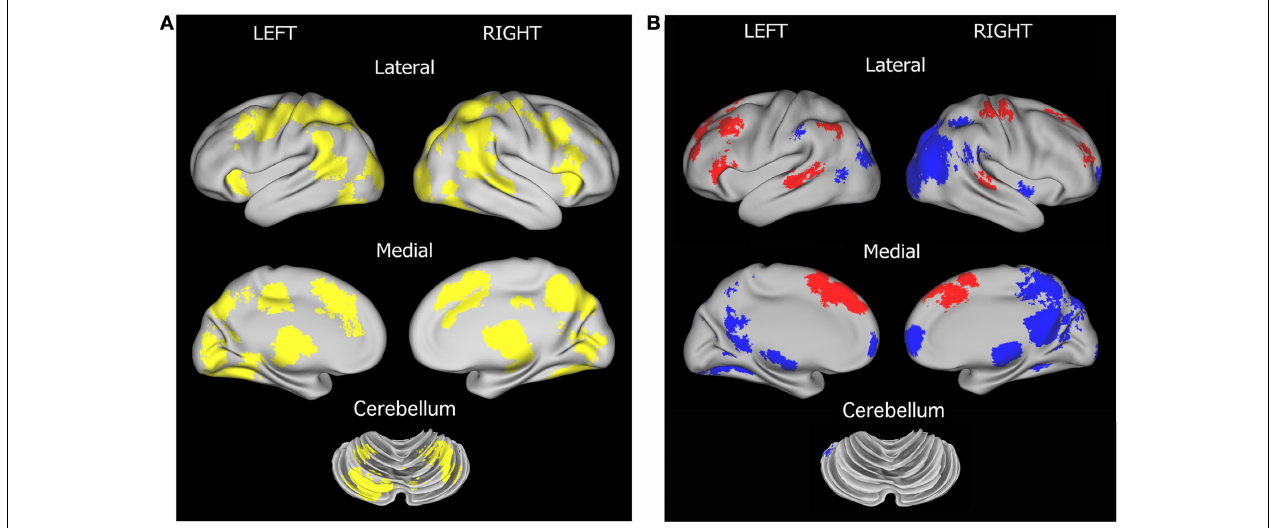
FIGURE 1 | Region sets for each signal type in the direct comparison of adolescent groups. (A) Regions with signifi cant start-cue activity are shown in yellow (main effect of time z -score > 3.5); (B) Regions with signifi cant sustained activity ( z -score > 3); Regions with positive sustained signal activity are shown in red, and Regions with negative sustained signal activity are shown in blue. The